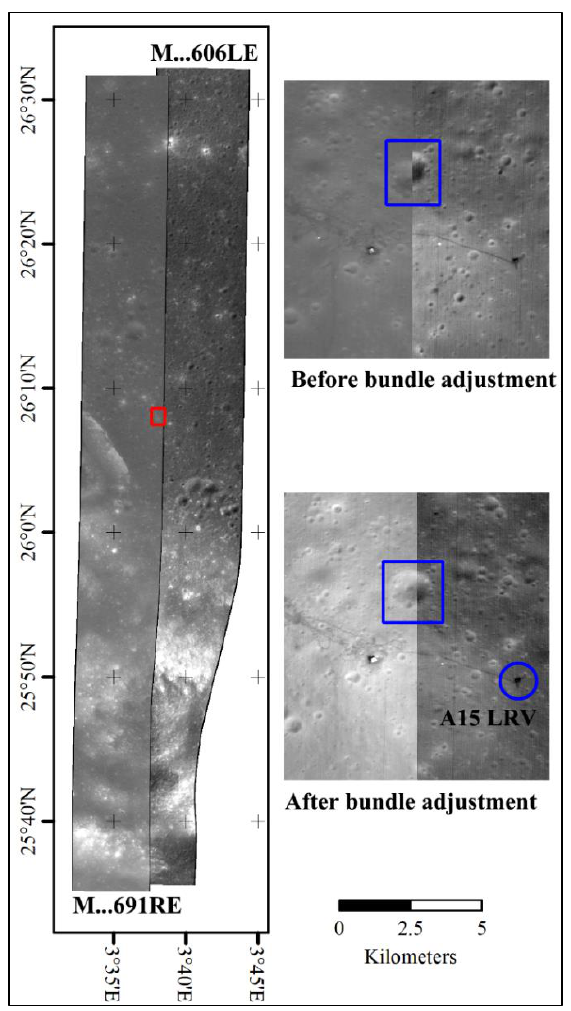
Figure 9. Image mosaics composed of the orthophotos derived from M109215691RE and M111578606LE images. A15 LRV indicates Apollo 15 Lunar Roving